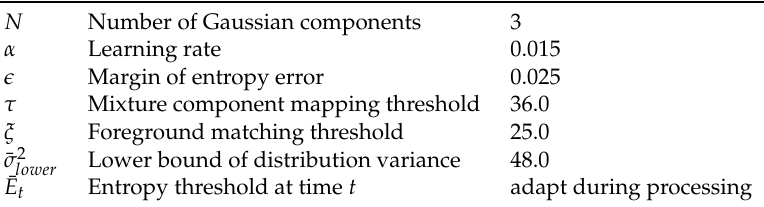
Table 1. Parameters in the